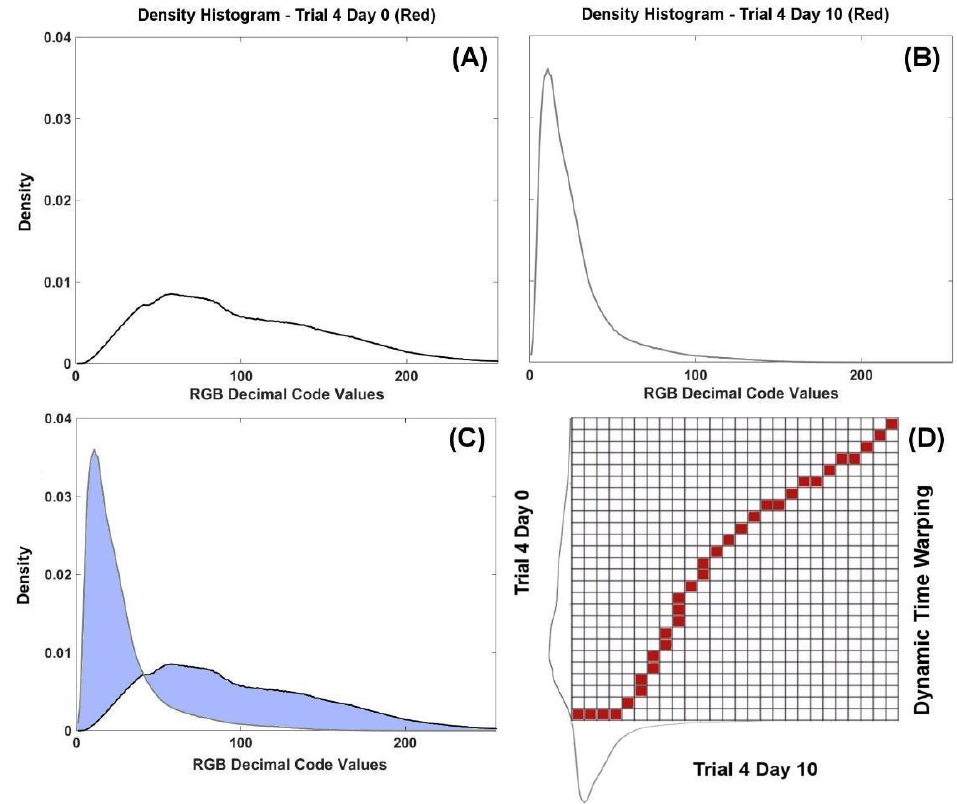
Figure 2. Density histogram profiles from pixel counts are provided for trial 4 day 0 in the red channel ( A ) and trial 4 day 10 in the red channel ( B ). ( C ) shows ( A , B ) plotted together, and the blue shaded area represents the area between both curves that does not overlap, i.e., is different. ( D ) is a representation of the Dynamic Time Warping (DTW) method applied to the same two curves in ( A , B ). The red squares represent the minimum distance between any two points when comparing the best fit of the two curves. The minimum distance at every point along the curves is then summed to create a single distance difference value representing the best fit between the two curves, or the amount of change necessary to make them as similar as possible.